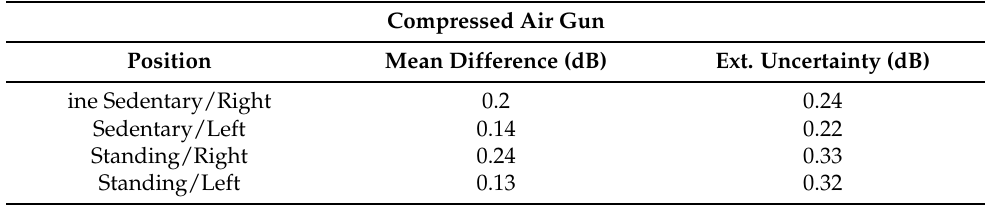
Table 3. Mean difference between the HiFUSPEx and the USPM, together with the extended mea- surement uncertainty calculated for measurements within the idealized set-up of a compressed air gun. Measurements performed with no protection grid mounted on the microphone cartridge.